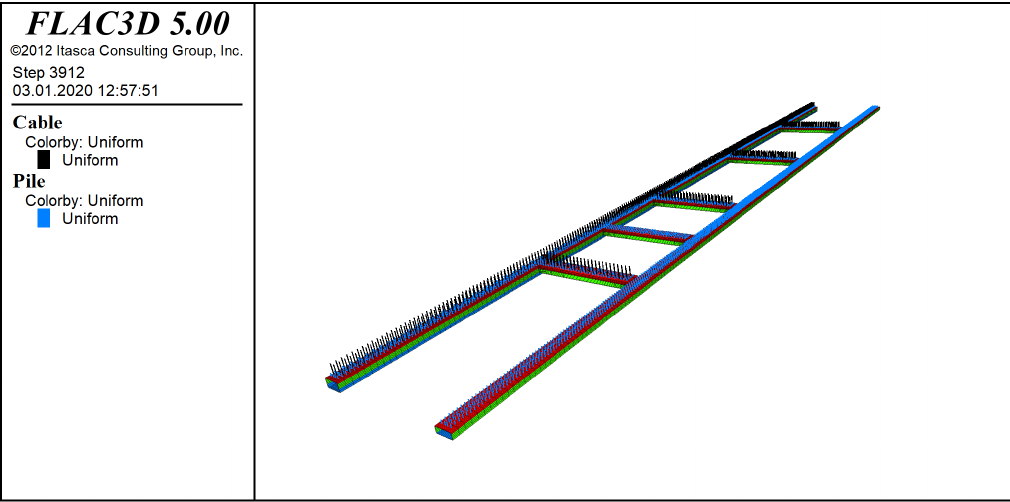
Figure 8: Cable elements (black) and rockbolt elements (blue) in a 3D